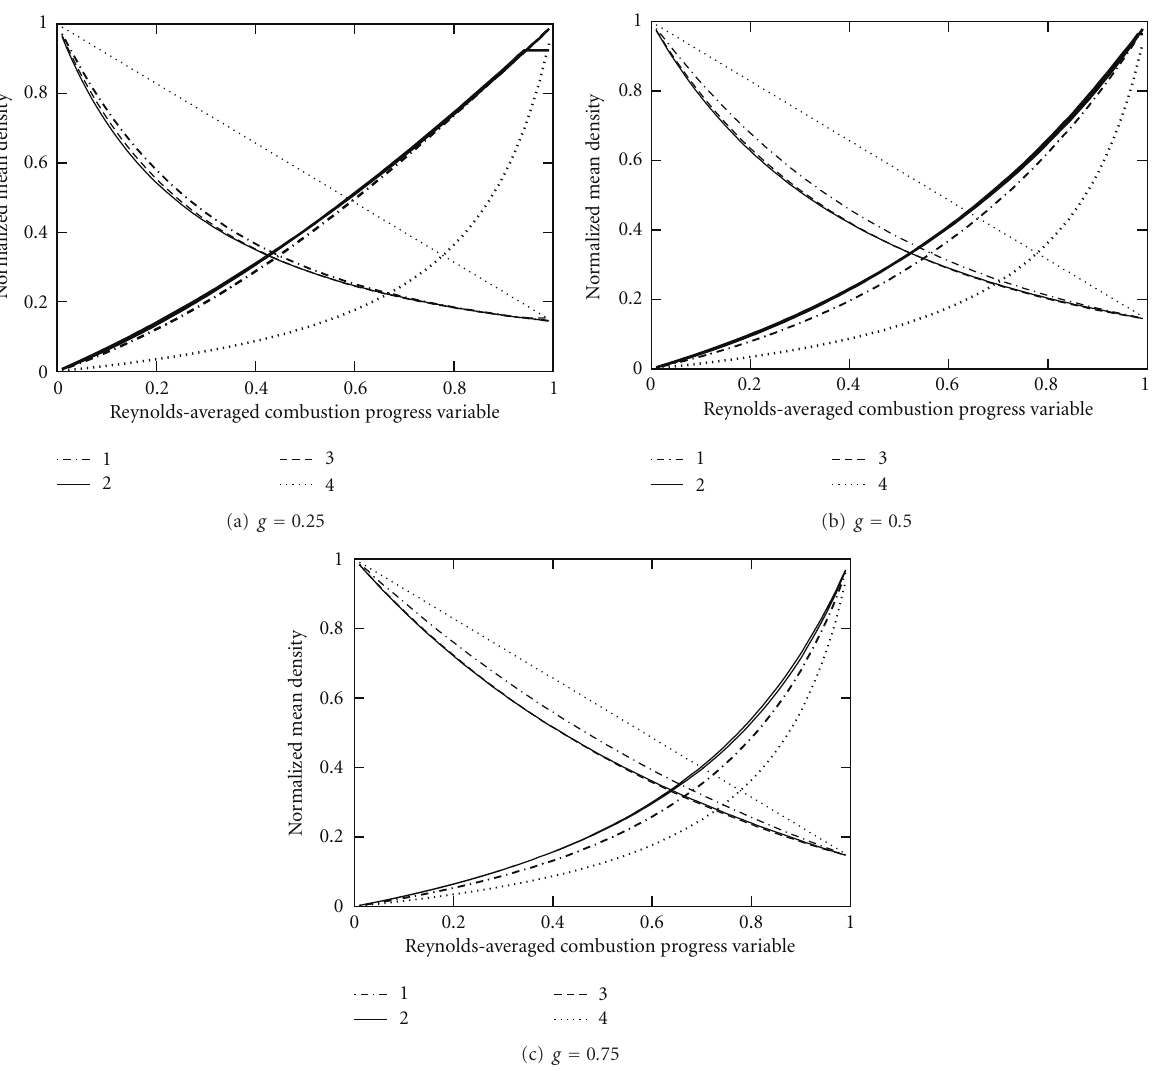
Figure 10: Dependencies of the normalized mean density (thin curves) and Favre-averaged combustion progress variable (cid:2) c (bold curves) on the Reynolds-averaged combustion progress variable, calculated invoking the beta-function PDF (curves 1), the R-2 δ -PDF (curves 2), the 2 δ -PDF (curves 3), and the BML equations (curves 4) for F = 1 . 0 and (a) g = 0 . 25, (b) g = 0 . 5, and (c) g = 0 .